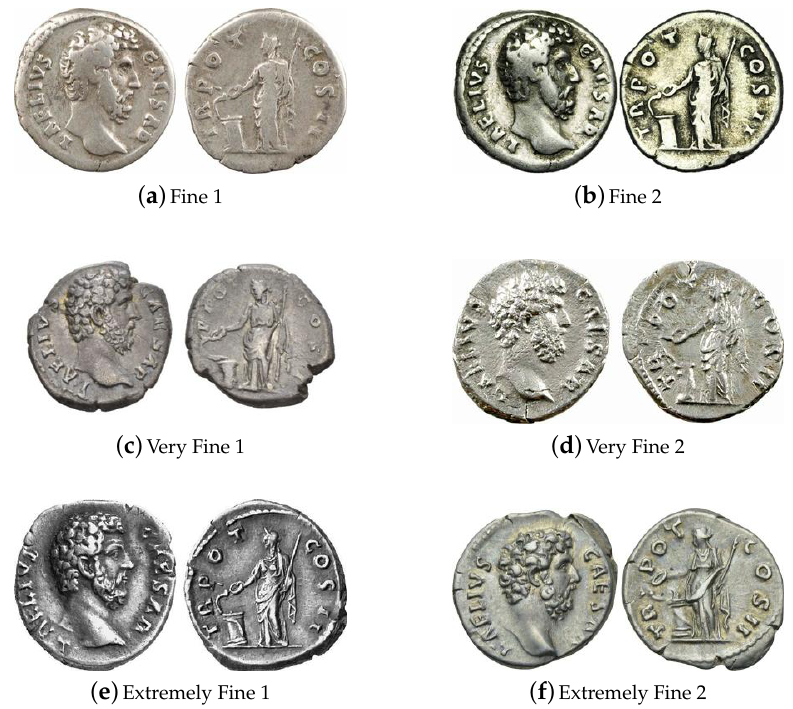
Figure 7. Our data set entry for Aelius Denarius RIC 434—there are images of two specimens for each of the three conditions included for all denarii issues in the data set (F, VF, and XF).